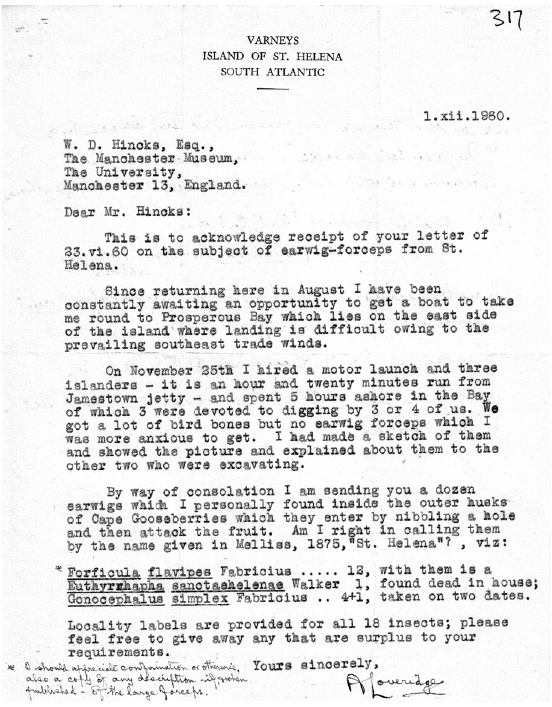
Fig. 13. Letter from Hincks to Arthur Love- ridge, 23 Jun. 1960 (MMUE, Hincks archive, item 360).